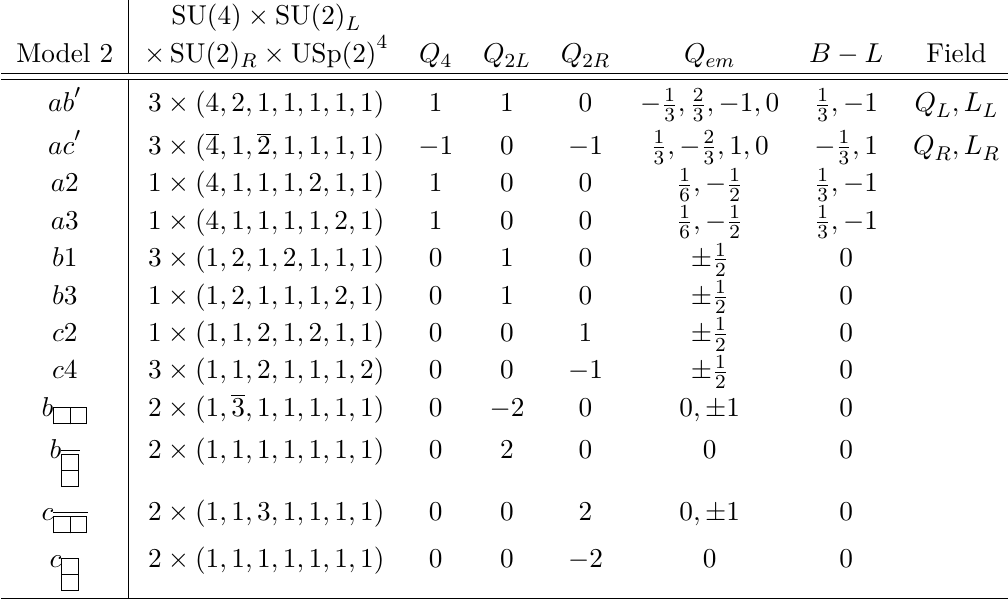
Table 3 . Chiral spectrum in the open string sector-Model 41.